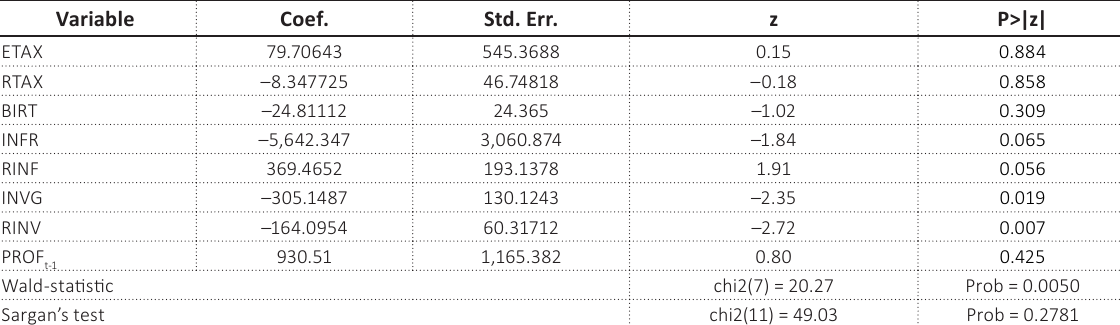
Table 8. Dynamic panel regression results of the service